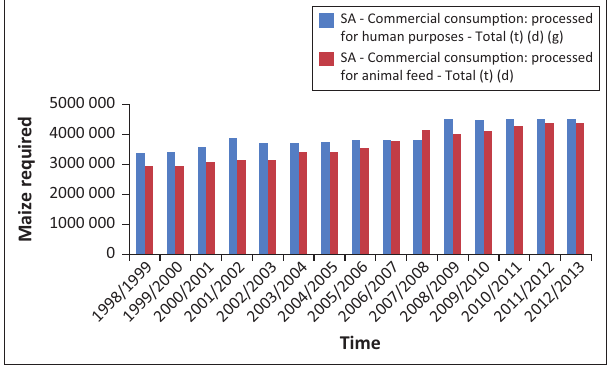
TABLE 3: Imports of maize into South Africa between 2003/2004 and 2014/2015.